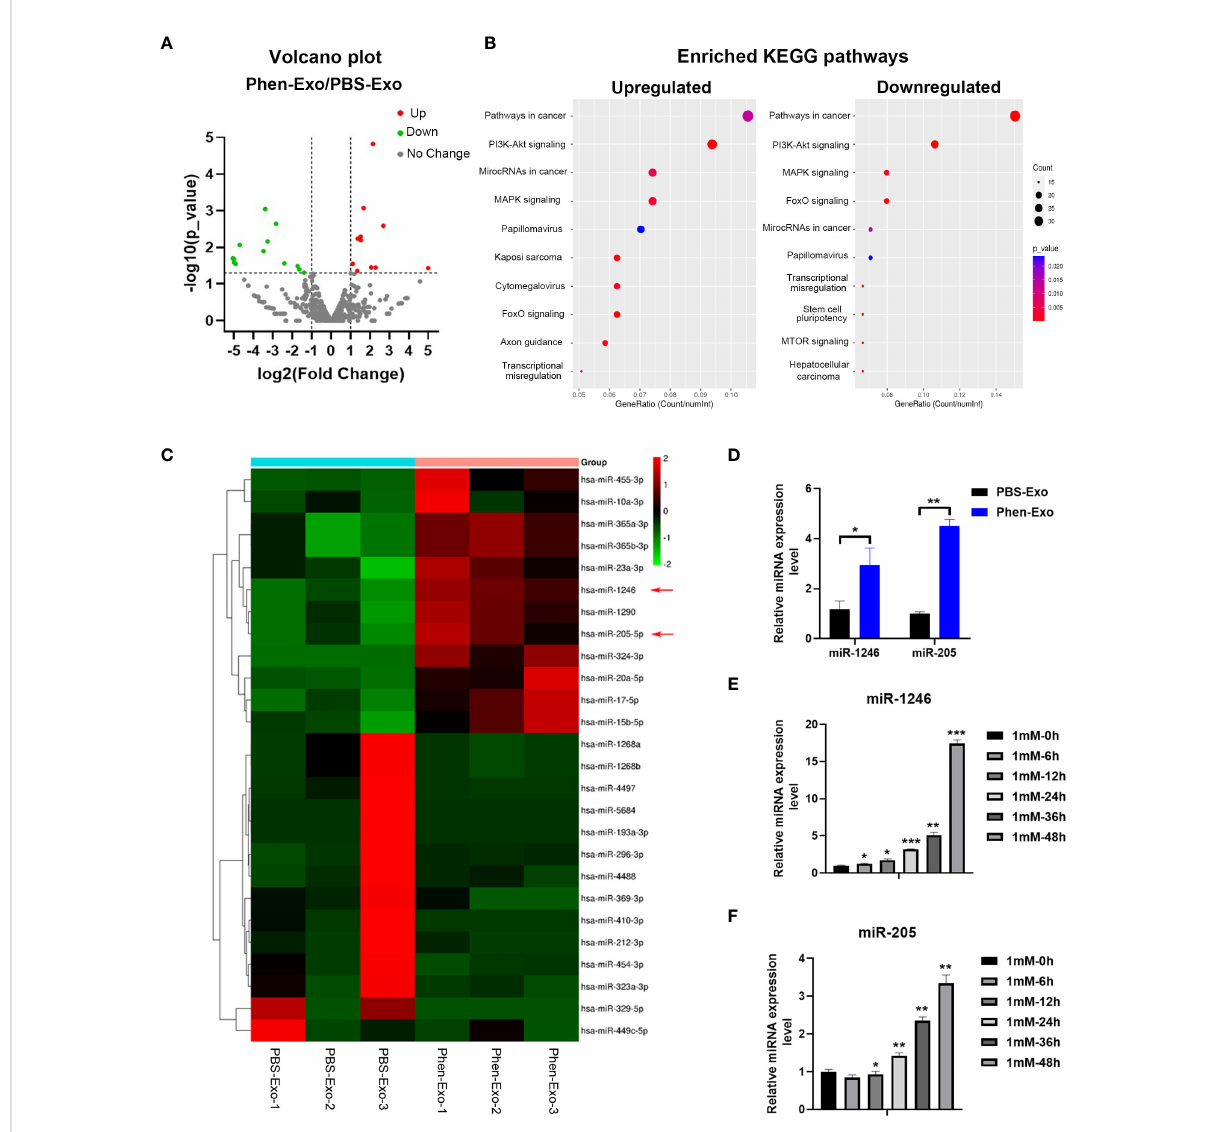
FIGURE 5 Phen-Exo derived from OSCC cells express high levels of miR-205 and miR-1246. (A) Volcano plot presenting differentially expressed miRNAs with a ≥ 2 fold difference between Phen-Exo and PBS-Exo. (B) The enriched KEGG pathway analysis of predicted target genes of top 10 up- regulated (Left) or down-regulated (Right) differentially expressed miRNAs. The X axis shows the enrichment factor; the left Y axis shows the top 10 positive KEGG pathway names (detail description of pathway name showed in Supplementary Table 1). The darker the color represents the smaller the p value. Bubble size indicates the number of differentially expressed miRNAs. (C) Heat map showing pro fi les of signi fi cantly upregulated and signi fi cantly down-regulated miRNAs in Phen-Exo vesus PBS-Exo. Red arrows indicate miR-1246 and miR-205. (D) qRT-PCR analysis of PBS-Exo and Phen-Exo derived from CAL 27 OSCC cells for expression levels of miR-1246 and miR-205. (E, F) qRT-PCR analysis of CAL 27 cells treated with 1 mM phenformin at 0, 6, 12, 24, 36, 48 h for expression levels of miR-1246 (E) and miR-205 (F) . (D – F) Relative expression levels were normalized by the human RNU6B gene. The error bars represent means ± SD in each group; P values are indicated with “ * ” , * indicates P<0.05, ** indicates P<0.01, *** indicates